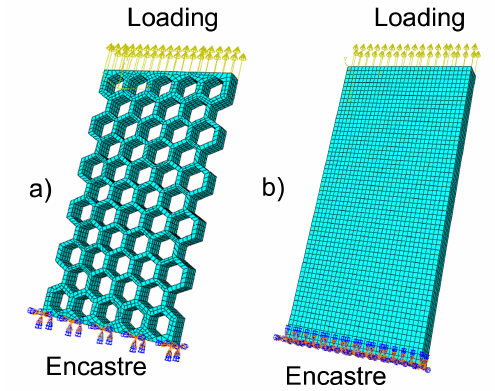
Figure 3. ( a ) Finite element model of the regular honeycomb structure. ( b ) Equivalent homogeneous material with the effective modulus E ∗ . The effective modulus E ∗ is chosen so that the equivalent material model has the same mechanical response as the honeycomb lattice